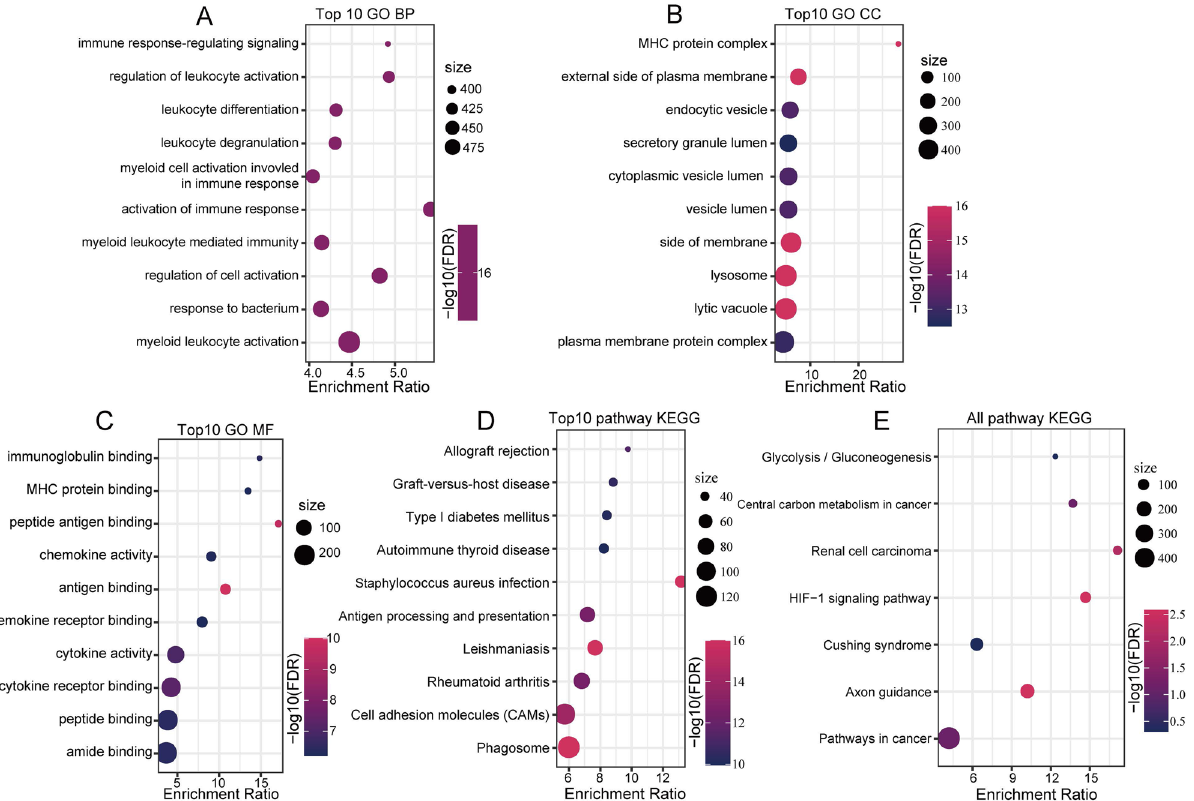
Figure 2. Pathway annotations for subtype-related differentially expressed genes (DEGs). ( A ) Pathway enrichment analysis of the upregulated DEGs using BP annotation. ( B ) Pathway enrichment analysis of the upregulated DEGs using CC annotation. ( C ) Pathway enrichment analysis of the upregulated DEGs using MF annotation. ( D ) Pathway enrichment analysis and annotation of the upregulated DEGs via KEGG analysis. ( E ) Pathway enrichment analysis and annotation of the downregulated DEGs via KEGG analysis.